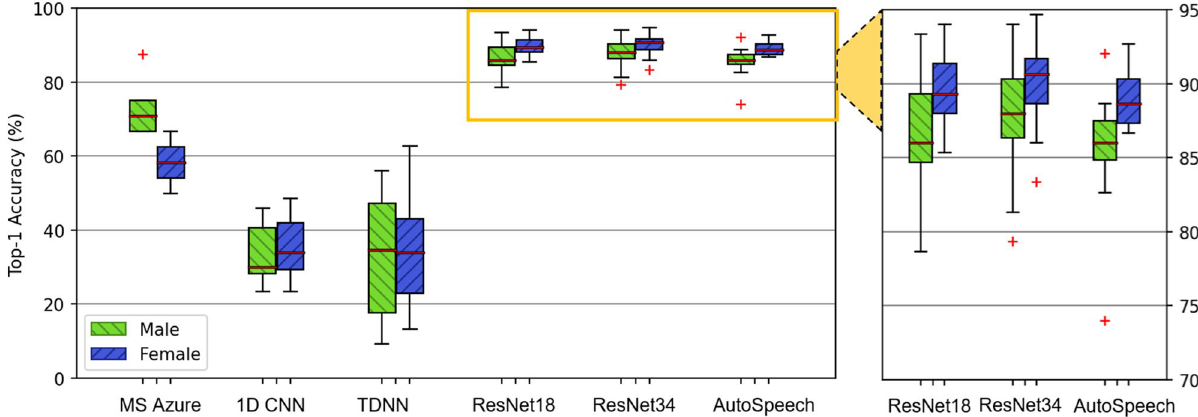
Figure 5. Voice identification performance among the matched gender dataset. The x-axis is gender subgroups. The y-axis is the percentage accuracy. ResNet-34 has the best overall accuracy. Significant differences between females and males are discovered in Microsoft Azure, ResNet-18, ResNet-34, and AutoSpeech. No significant differences in TDNN and